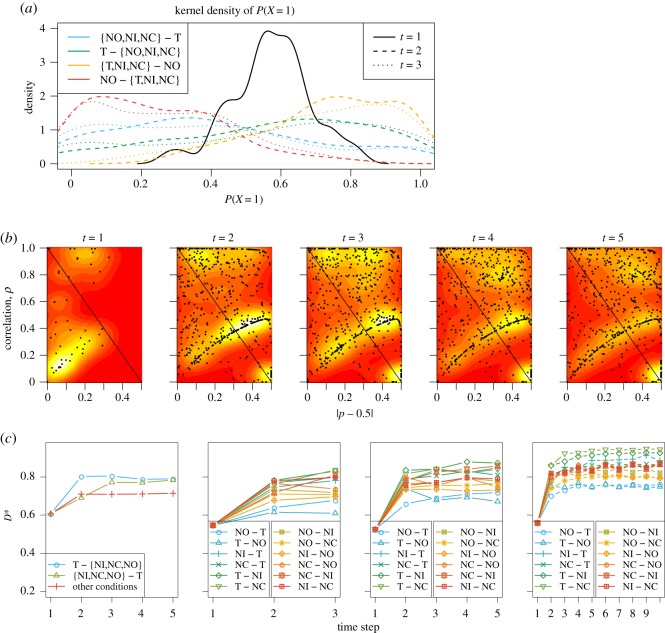
Experimental data: results for the HMM. (a) Kernel density representation of the estimates of pt, the probability of attending to the contralateral stimulus, obtained using I = 3 and all 12 conditions (combined for presentation). At t = 1, all conditions follow the same distribution, so there is a single black curve. For the subsequent time steps, the condition types are: stimulus pairs with T on the ipsilateral side; stimulus pairs with T on the contralateral side; stimulus pairs with NO on the ipsilateral side; and stimulus pairs with NO on the contralateral side. (b) Estimates of correlation ρ against estimates of probability extremeness |p − 0.5| at the different time steps obtained using I = 5 and all 12 conditions, on top of a two-dimensional kernel density estimate as heatmaps serving as a visual tool presenting smoothed estimates of the tendency of parallel/serial processing from the point estimates. Yellow implies higher point density, red implies lower point density. (c) Estimates of D* (equation (2.2)) using three merged conditions with I = 5 (left), all 12 conditions with I = 3 (middle left), I = 5 (middle right), and I = 10 (right).